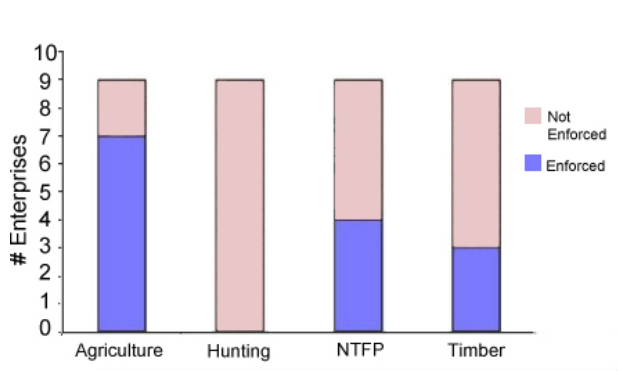
Fig. 6 . Enforcement of local uses restrictions in nine